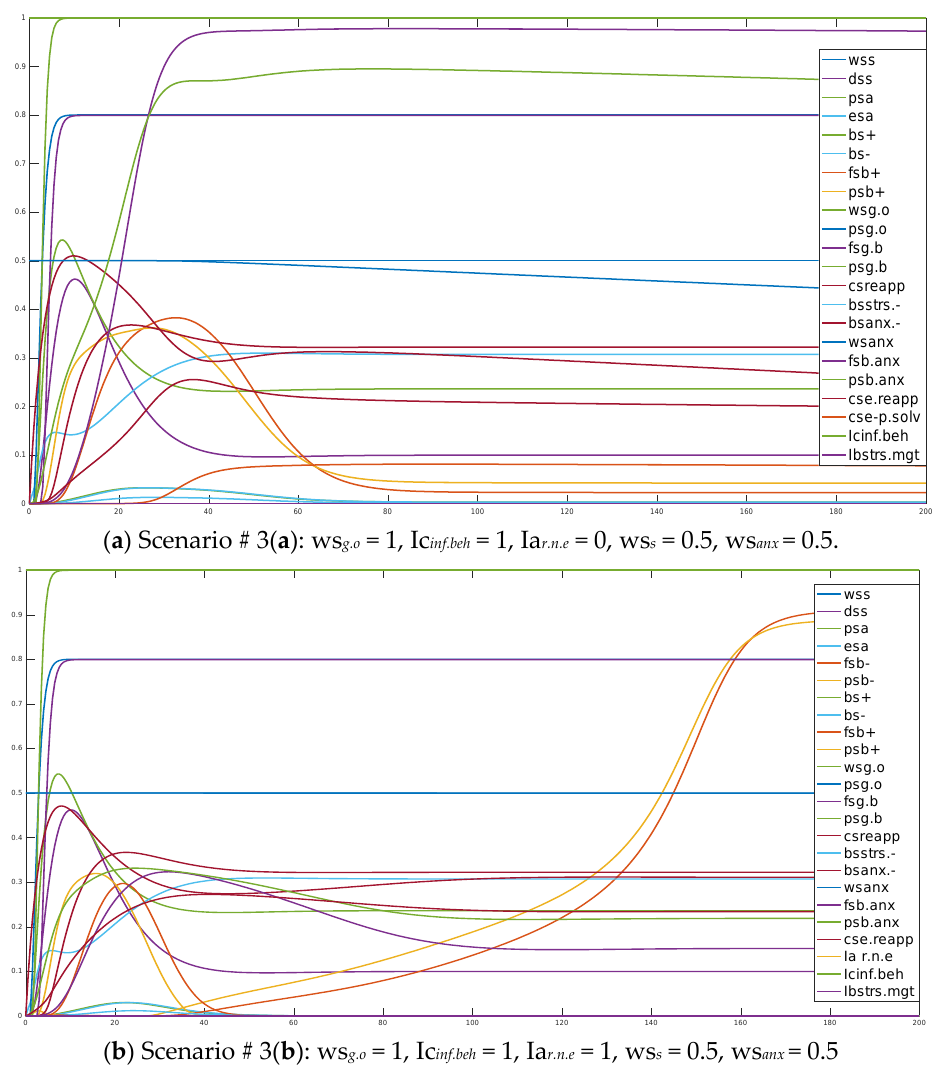
Figure 4. ( a ) Success in low intensity desire regulation but failure in emotion regulation. ( b ) Success in low intensity desire and emotion regulation.